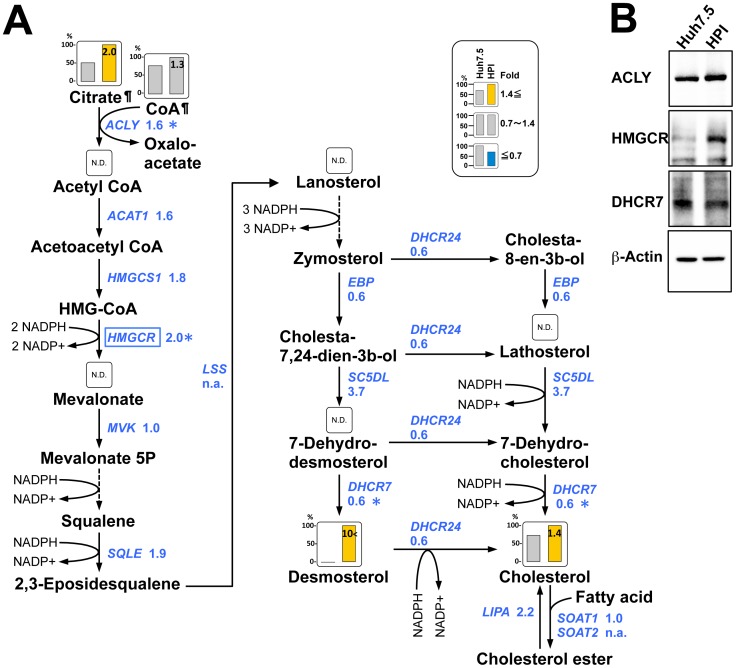
Biosynthetic pathway of cholesterol.(A) Relative quantities of metabolites in Huh7.5 (left column) cells and HPI cells (right column) are superimposed on a metabolic map of the cholesterol biosynthesis pathway according to the data (Table S1, Table S2). The metabolic map is depicted based on KEGG pathways (http://www.genome.jp/keg/). The NADPH/NADP+ reaction, if associated, was added to the main reaction. Height of column with larger quantity is set to 100%, and that of smaller quantity are shown proportionally. Numbers on the right columns indicate the fold-change of HPI compared to Huh7.5, and the color of the column represents: yellow (> = 1.4-fold), blue ( = <0.7-fold), or gray (0.7∼1.4-fold). ¶: A metabolite appearing on other figure. Genes (italicized) located between metabolites encode enzyme(s) for a corresponding reaction with fold-expressions of HPI to Huh7.5 according to the data (Table S3). A gene encoding a rate-limiting enzyme is surrounded by a square. *: Immunoblot analysis was also done for confirmation in (B). N.D.: Not detected. n.a.: Not assessed because of low expression. (B) Immunoblot analysis of the selected enzymes. Beta-actin was used as a control.